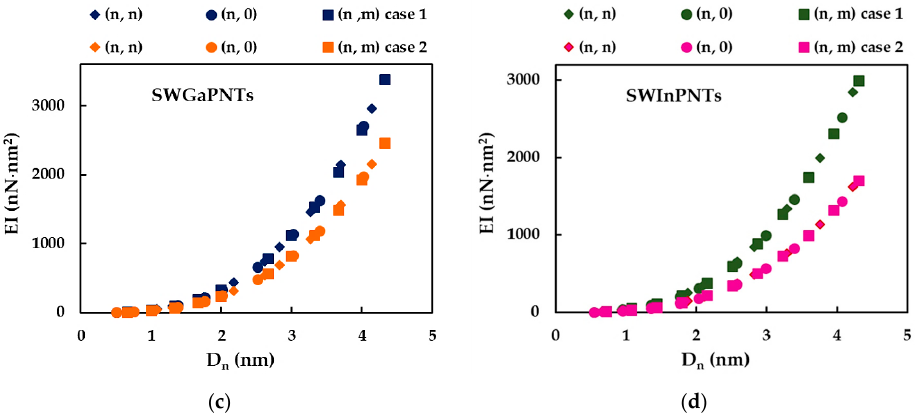
Figure 7. Evolution of bending rigidity, EI, as a function of the nanotube diameter, D n , for: ( a ) SWBPNTs; ( b ) SWAlPNTs; ( c ) SWGaPNTs; and ( d ) SWInPNTs.